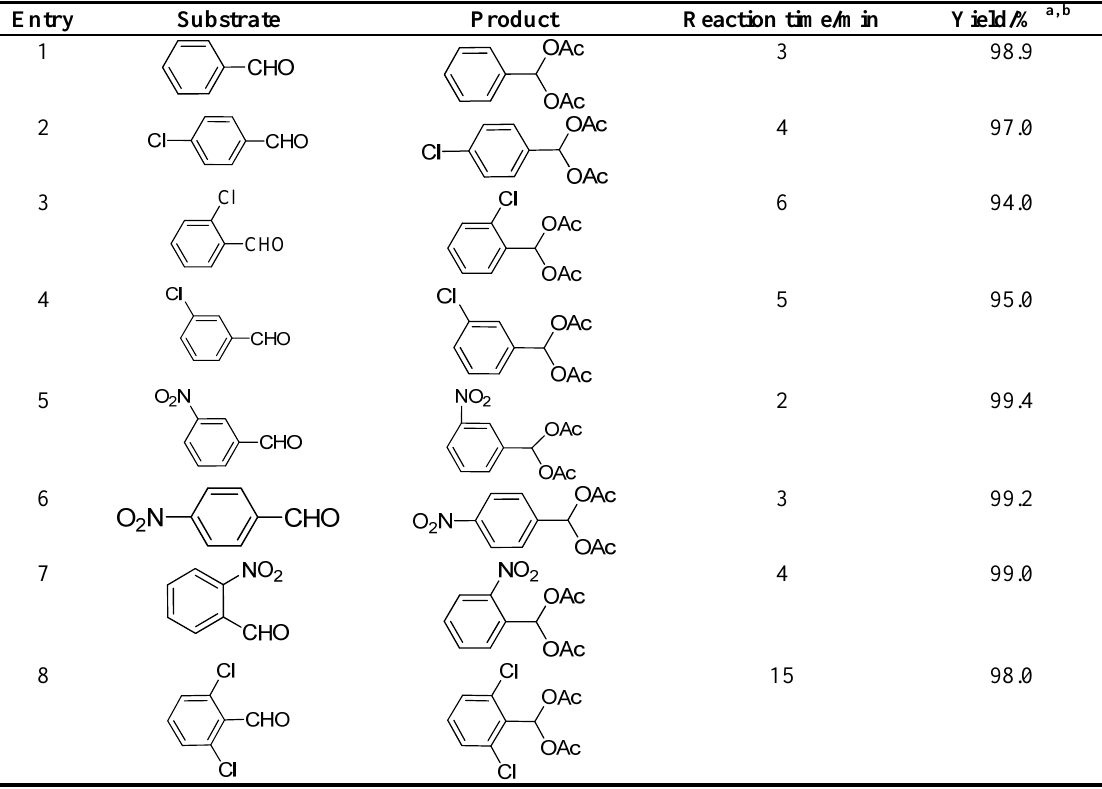
Table 1. The results with various carbonyl